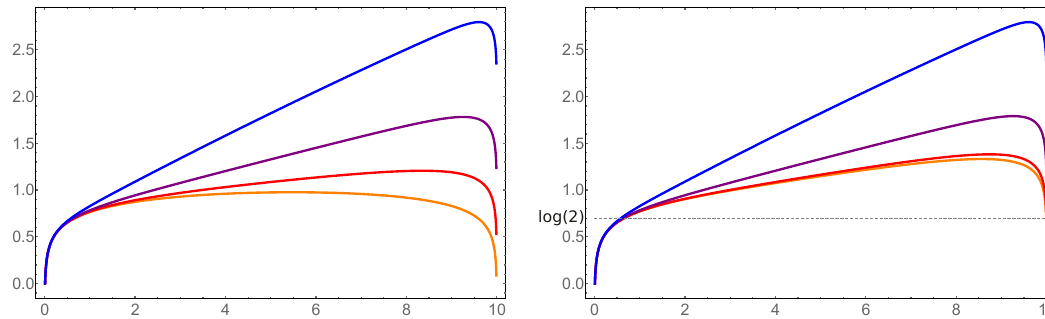
Figure 8. Entropy for a single interval as a function of its length ‘ , for di(cid:11)erent values of (cid:12) ( (cid:12) = 2 ; 4 ; 8 ; 16 from top to bottom) and L = 10. The left and right panels correspond respectively to Neveu-Schwarz ( (cid:23) 1 = 1) and Ramond ( (cid:23) 1 = 0) boundary conditions. At high temperatures the entropy is almost linear because thermal e(cid:11)ects dominate over entanglement. At zero temperature, the Neveu-Schwarz entropy is symmetric with respect to the point ‘ = L= 2 because the (cid:12)eld is in a pure state. Contrarily, the Ramond entropy does not exhibit this behavior because the (cid:12)eld is in a mixed state in which the zero mode has 1 = 2 probability of being empty or occupied. Correspondingly, the entropy in this case approaches the value S = log 2 as ‘ ! L